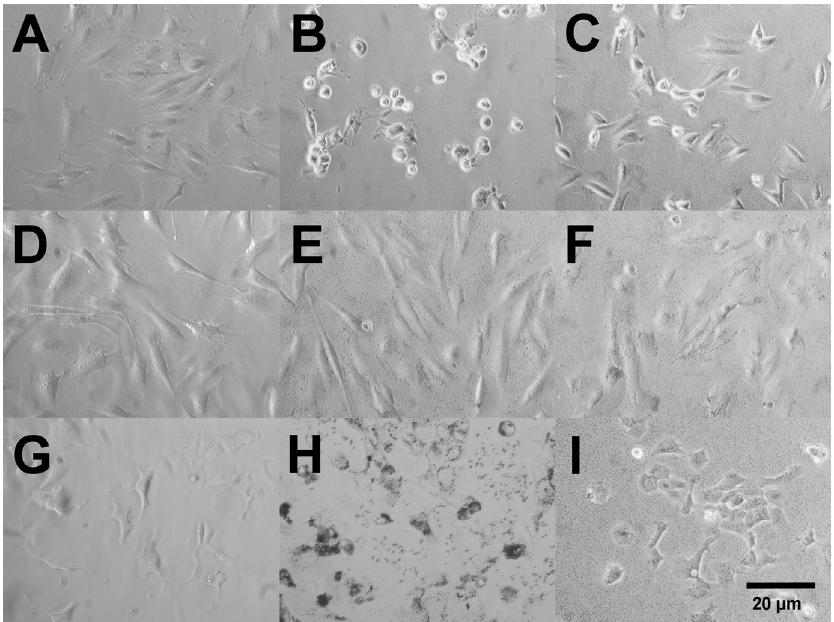
Figure 8. Phase contrast images of confluent murine epithelial cells at 4 h post particle exposure. ( A ) Control LA4 cells with no particle exposure; ( B ) LA4 cells exposed to 50 µg/mL 20 nm citrate-stabilized Ag nanospheres; ( C ) LA4 cells exposed to 50 µg/mL 110 nm citrate-stabilized Ag nanospheres; ( D ) Control C10 cells with no particle exposure; ( E ) C10 cells exposed to 50 µg/mL 20 nm citrate-stabilized Ag nanospheres; ( F ) C10 cells exposed to 50 µg/mL 110 nm citrate-stabilized Ag nanospheres; ( G ) Control MLE12 cells with no particle exposure; (H ) MLE12 cells exposed to 50 µg/mL 20 nm citrate-stabilized Ag nanospheres; ( I ) MLE12 cells exposed to 50 µg/mL 110 nm citrate-stabilized Ag nanospheres. Magnification at 200× for all